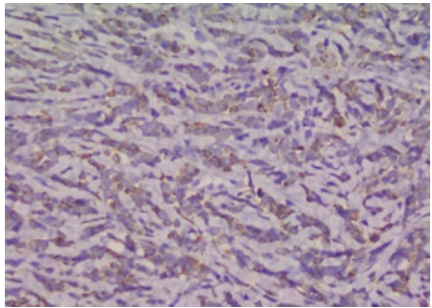
Figure 3: Immunohistochemistry showing MPO immunoreactivity in the cytoplasm of the neoplastic cells ( × 400, myeloperoxidase